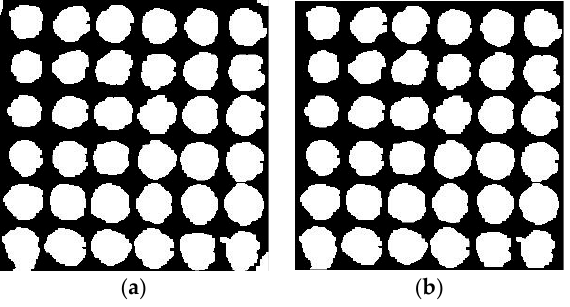
Figure 9. ( a ) processing result of value component; ( b ) removal of boundary noise.